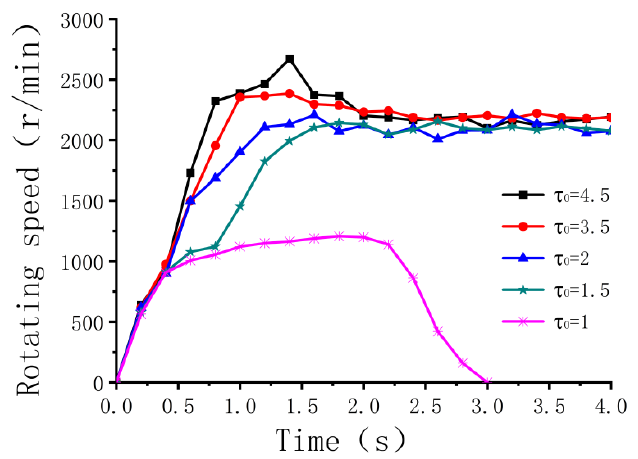
Figure 13. Rotation speed curves for different concentration coefficients during a cold start.